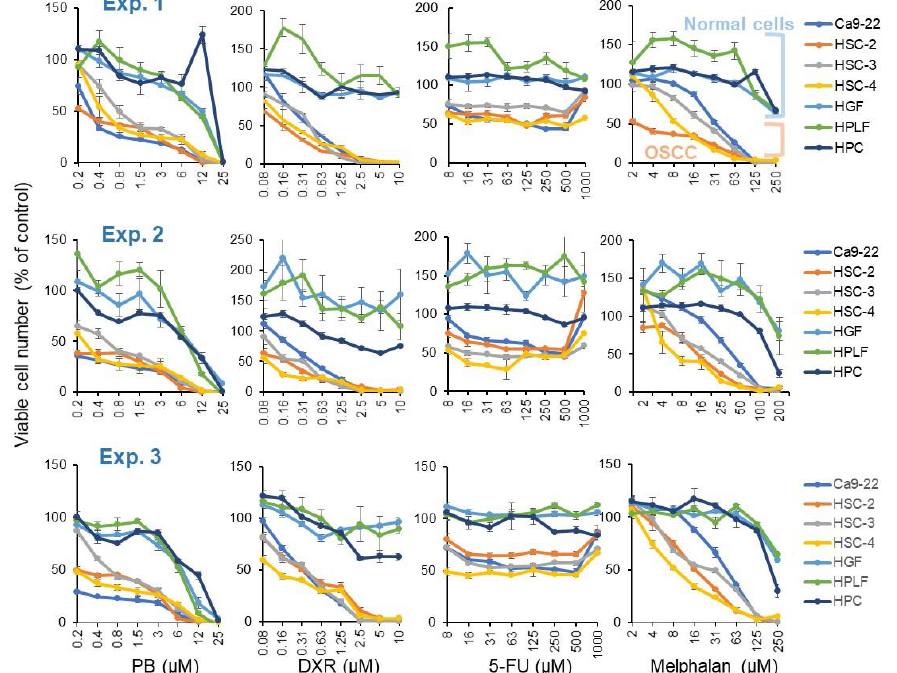
Figure 2. Dose–response curve of cytotoxicity of pyoktanin (PB) and three anticancer drugs (DXR, 5-FU and melphalan). Cells were incubated for 48 h with the indicated concentrations of test compounds. Experiments were repeated three times. Each value in each panel represents mean ± S.D. of triplicate assays. PB, pyoktanin blue; DXR, doxorubicin; 5-FU, fluorouracil.